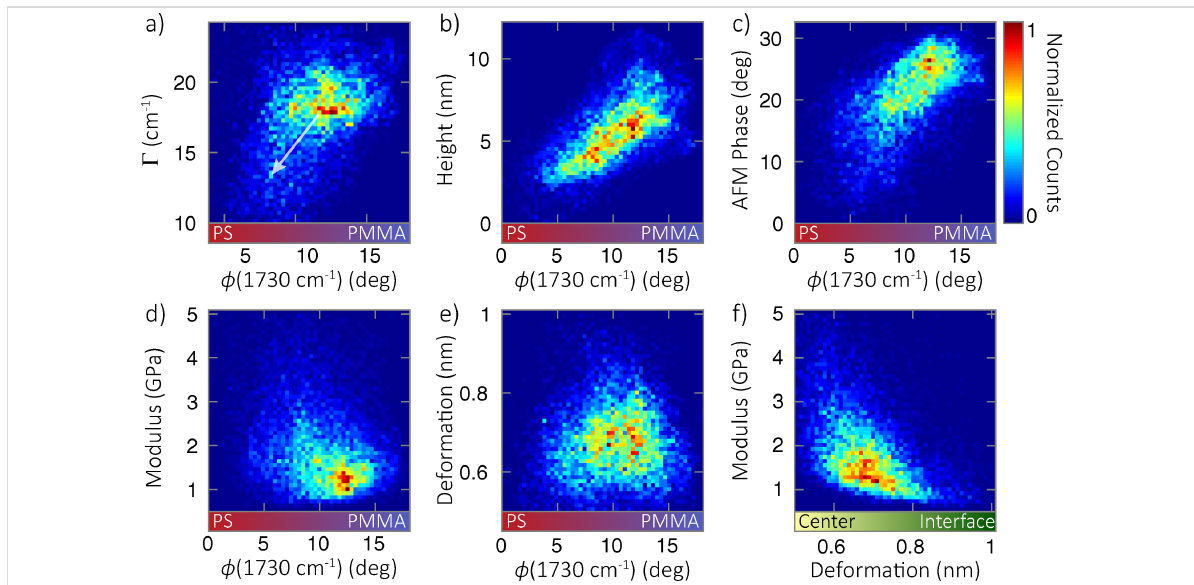
Figure 4: Bivariate histograms, showing the correlations between different signal channels across the entire image region. The arrow in (a) indicates that the correlation is seen to continue towards the lower left until Γ becomes undefined in nonresonant, PS-rich regions. Colored bars along the hori- zontal axes illustrate the correspondence of the spectral phase with PMMA concentration, or deformation with interfacial mixing (center vs